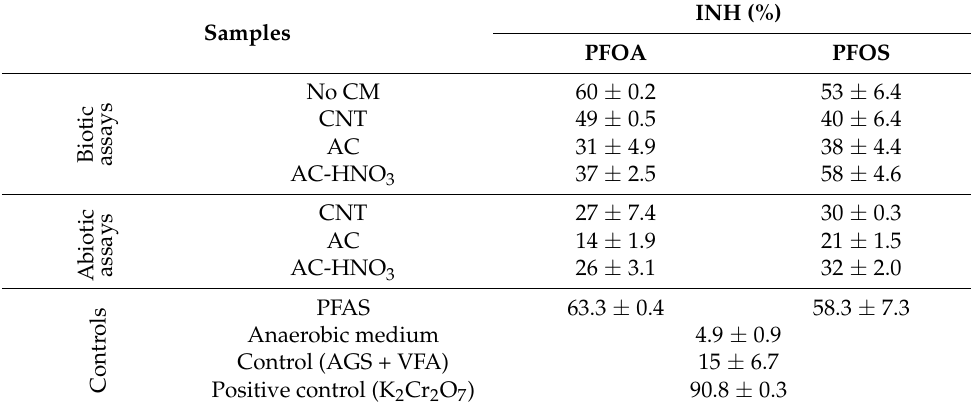
Table 4. Luminescence inhibition (INH) of Vibrio fischeri caused by PFAS samples after 6 days of anaerobic treatment in the presence and absence of different CM. INH (%) Samples PFOA